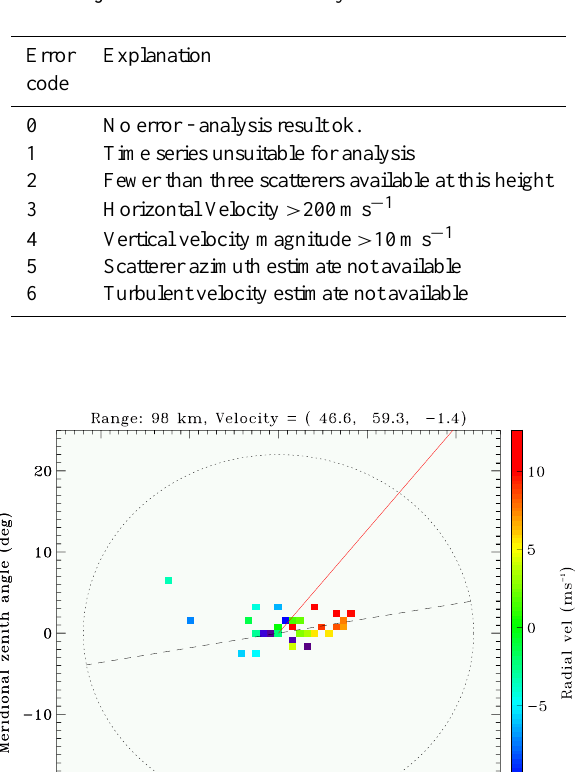
Table 1. Rejection criteria for IDI analysis.